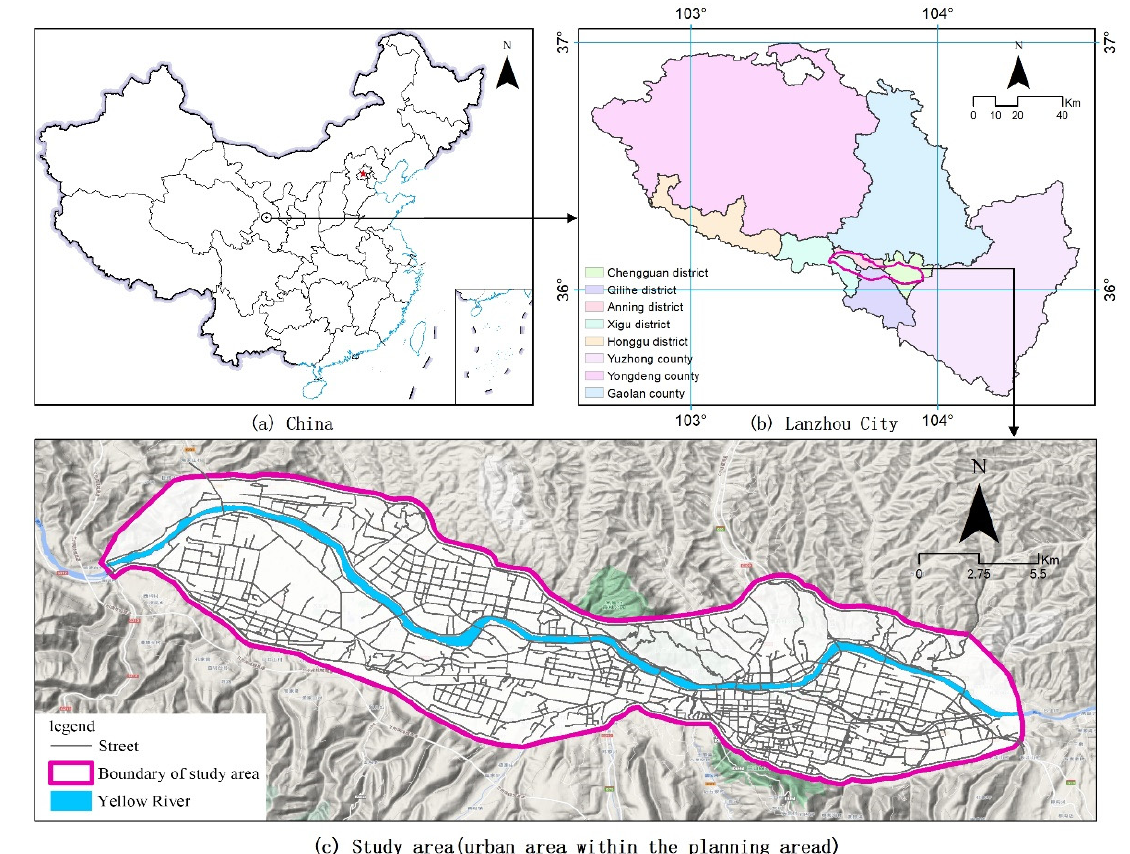
Figure 1. Location of the study area.